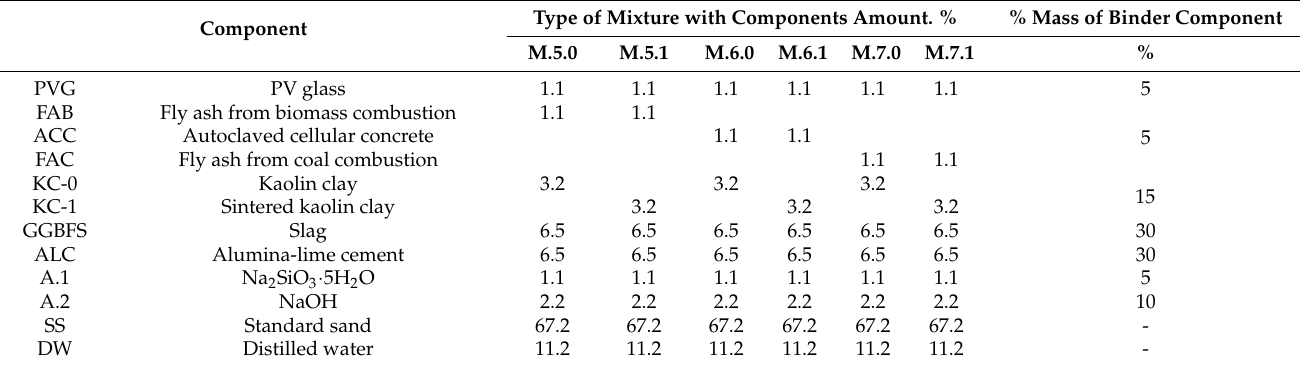
Table 5. Quantitative and qualitative compositions of mixtures, in